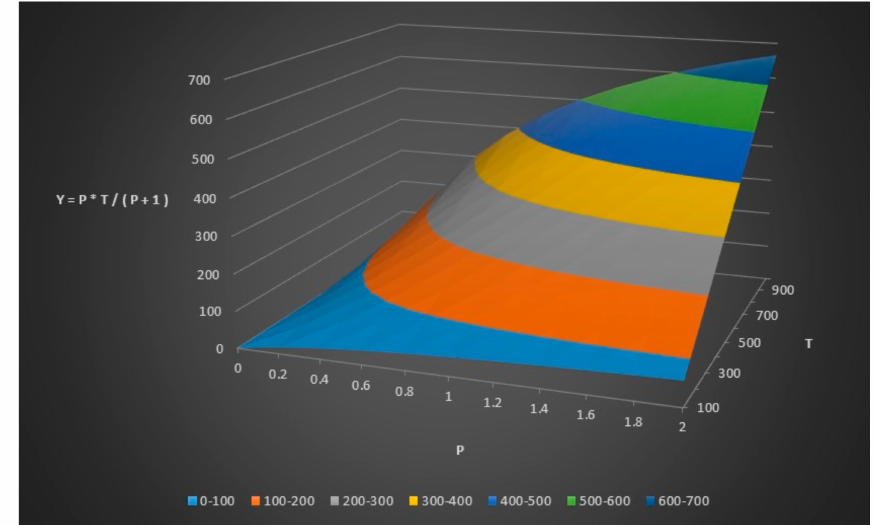
Figure 7. The number of healthy people in the control group (y) given the total number of people (T) and the relationship (p) between x and